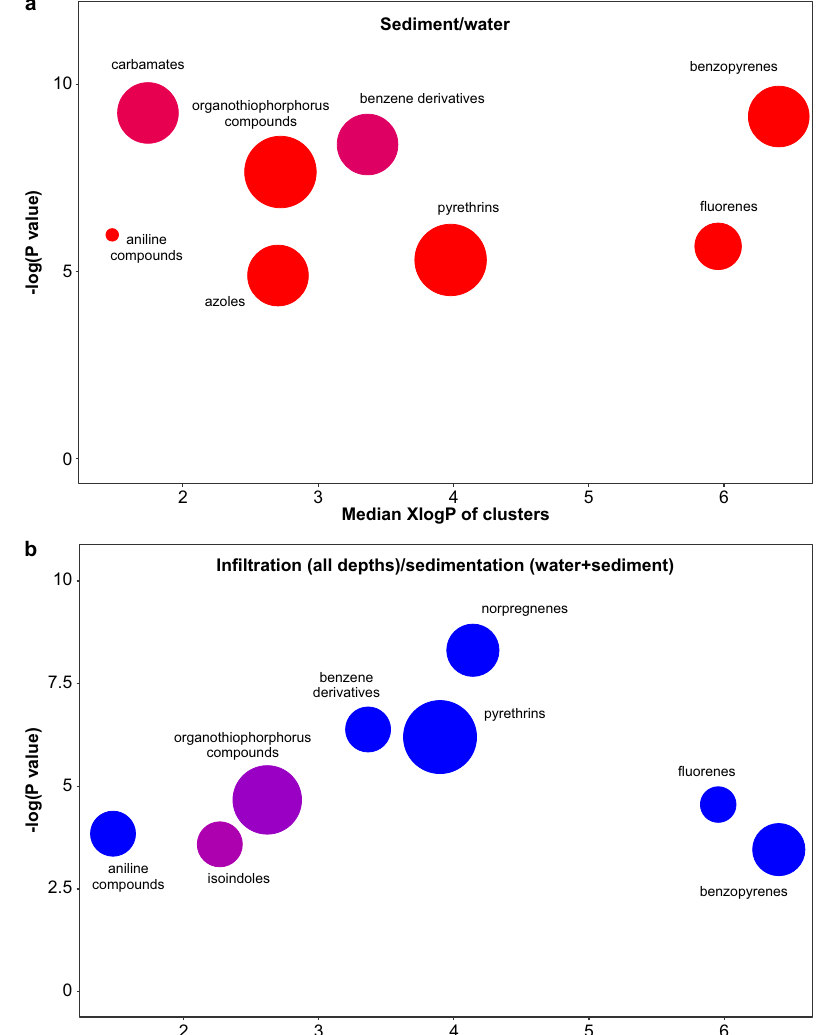
Fig. 2 Chemical enrichment analysis of sediment/water and in fi ltration/sedimentation samples. Signi fi cantly impacted metabolite clusters ( P < 0.05) are depicted in red (increased) and blue (decreased). The most signi fi cantly altered clusters are shown on the top of the y -axis; clusters are distributed on the x -axis based on their partition coef fi cient (hydrophilic compounds on the left and hydrophobic compounds on the right). The size of the circles indicates the number of compounds in each cluster. a Chemical enrichment between sediment and water and b chemical enrichment analysis between in fi ltration (all depth) and sedimentation (water + sediment). Chemical enrichment statistics were calculated by the Kolmogorov – Smirnov